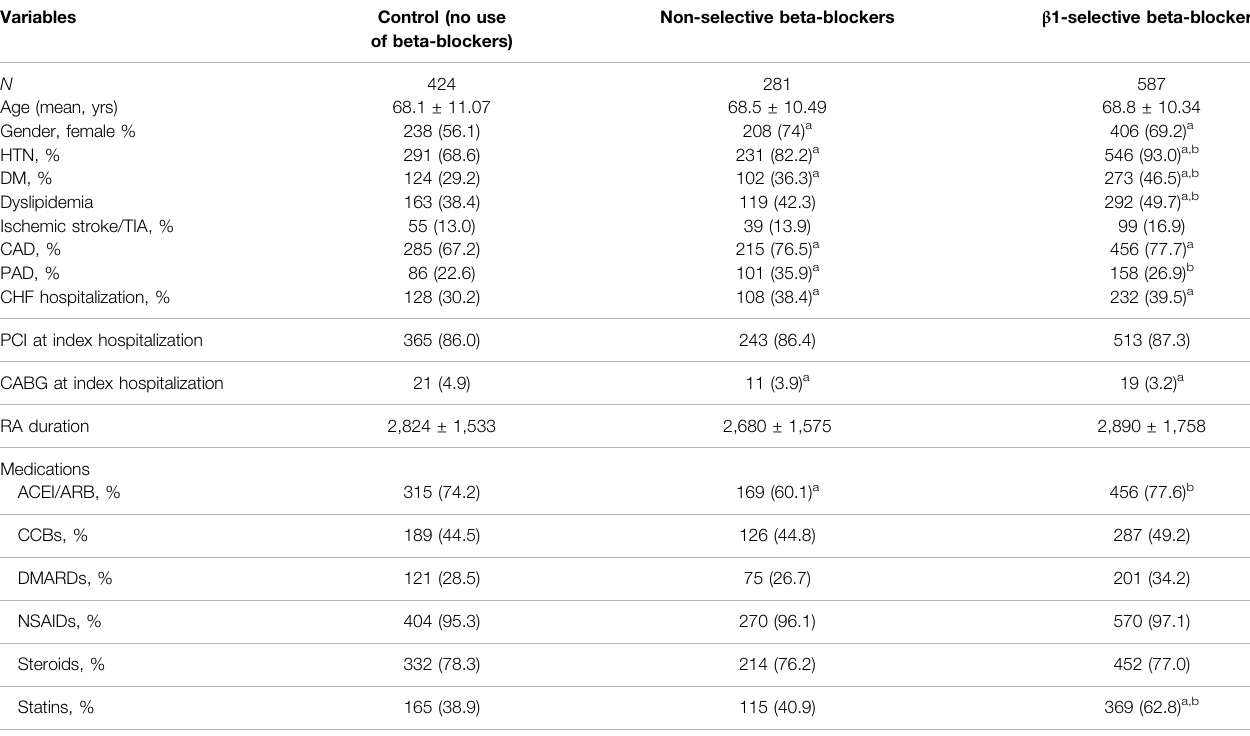
TABLE 2 | Patient baseline characteristics strati fi ed by prescription of beta-blockers before and after propensity matching. Variables Control (no use of